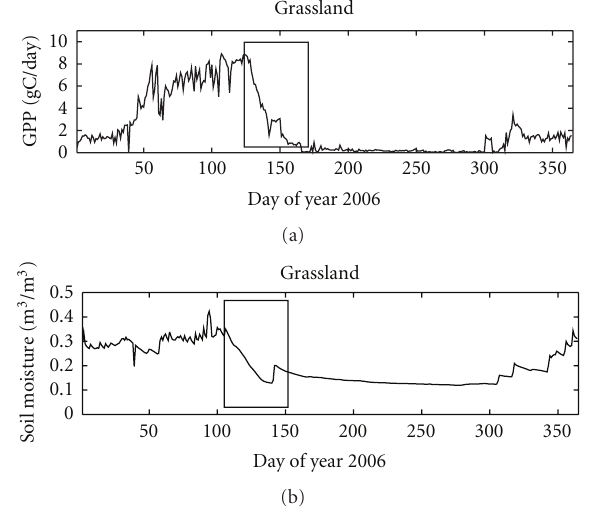
Figure 2: An example of decreasing GPP in agreement with declin- ing soil moisture. Seasonal variation in GPP and soil moisture at 10cm in 2006, the highlighted part showing the declines in GPP and soil